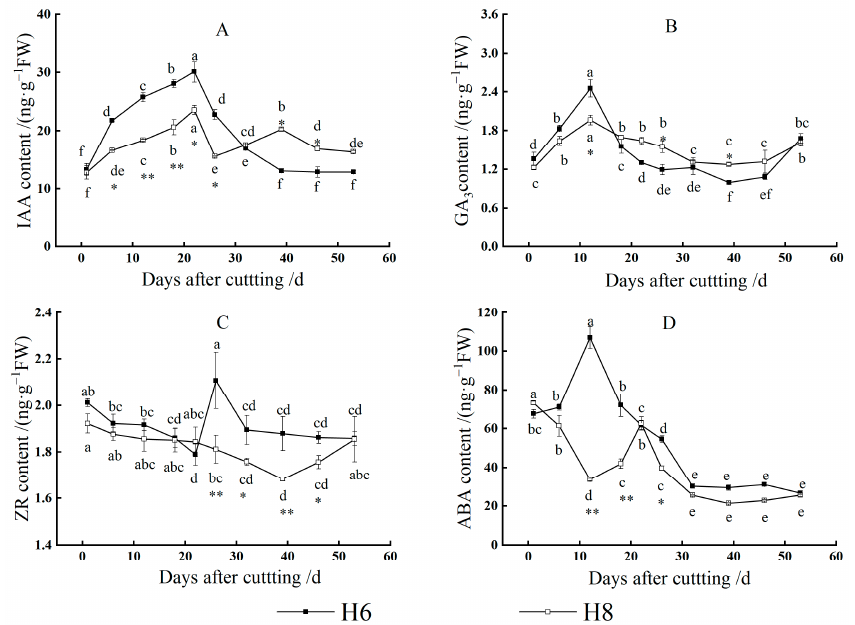
Figure 5. Changes of endogenous hormones in cutting rooting of H6 and H8 in E. ulmoides . ( A ) Changes in IAA content. ( B ) Changes in GA 3 content. ( C ) Changes in ZR content. ( D ) Changes in ABA content. IAA—Indole–3–acetic acid; GA 3 —Gibberellic acid 3; ZR—Zeatin riboside; ABA— Abscisic acid. The data are shown as the means ± SEs ( n = 3). Means with the same letter are not significantly different in the same group. * indicates significant difference between the H6 group and the H8 group at the same time. * and ** indicate means at the level of 0.05 and 0.01, respec- tively.